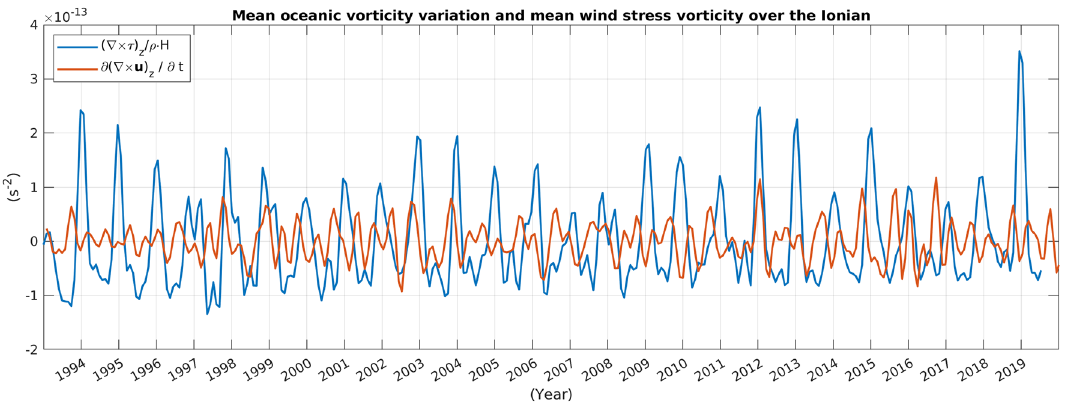
Figure 1. Low-passed (cutoff frequency 1/120 days -1 ) vorticity source due to wind stress in the period 1 Jan, 1993–19 Aug, 2019 (blue line) and variation in the oceanic relative vorticity in the period 1 Jan, 1993–31 Dec, 2019 (red line), averaged over the NI (with reference to Fig. S4, the “Eddy Region”). Correlation between red and blue line: − 0.021. This figure has been created using MATLAB software package version 2018a (www. mathw orks.